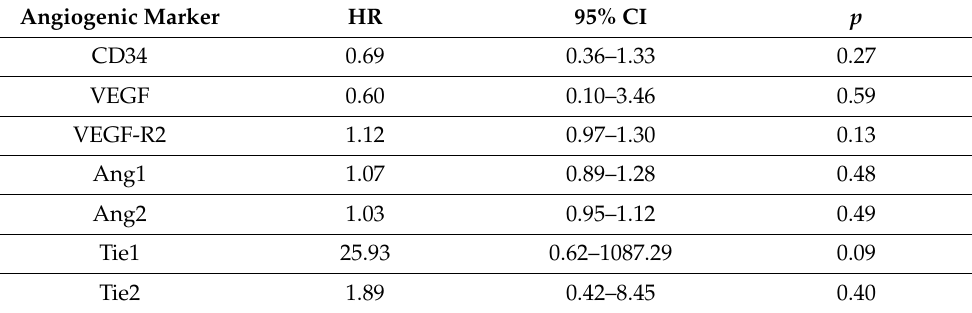
Table 3. Overall survival in patients with ACC. Angiogenic